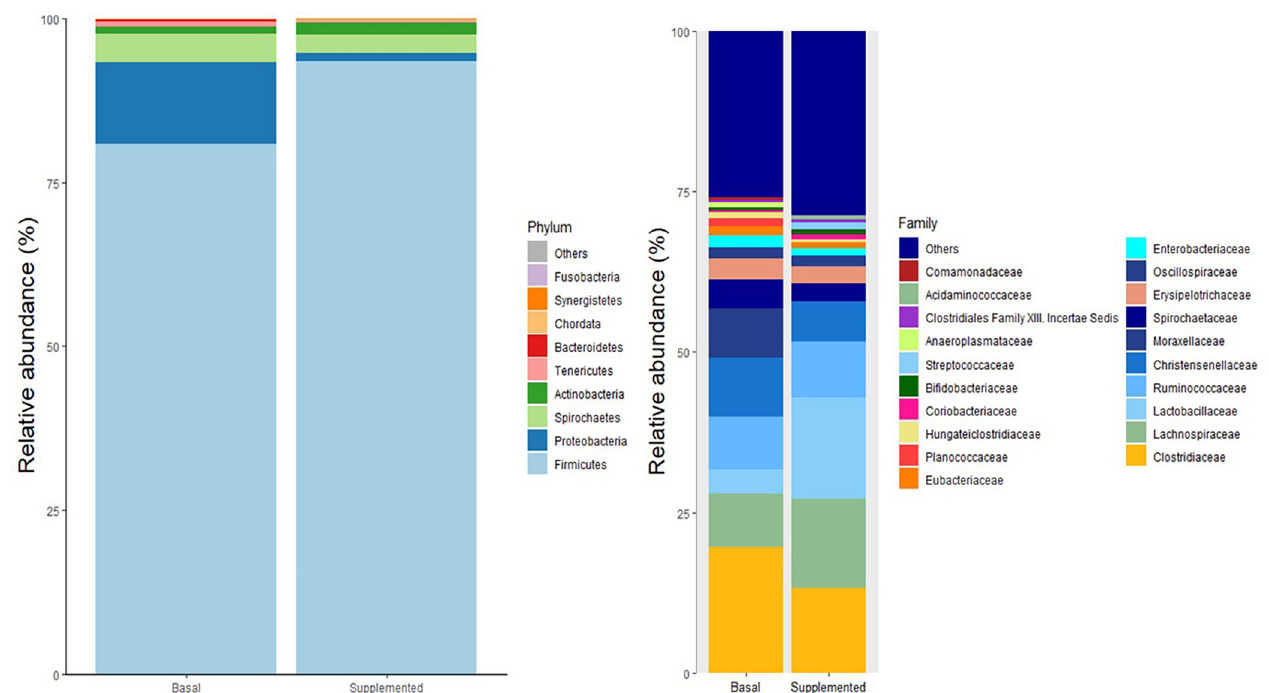
Fig 3. The relative abundance of bacterial taxa at the phylum and genus level in sow faeces at expected day of farrowing.